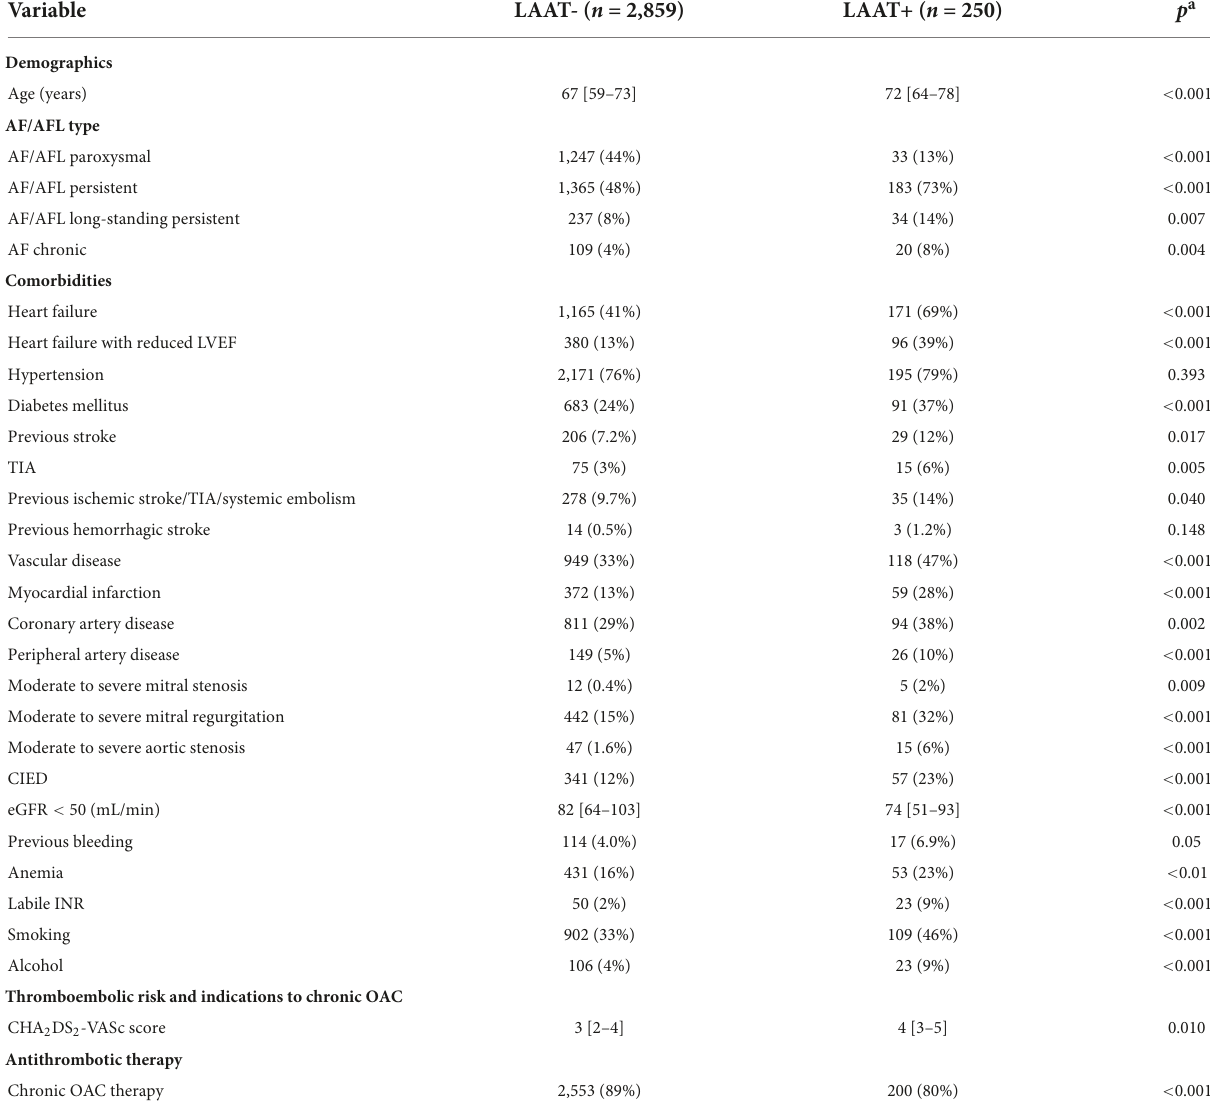
TABLE 1 Comparison of the clinical characteristics between patients with (LAAT+) and without LAAT (LAAT).